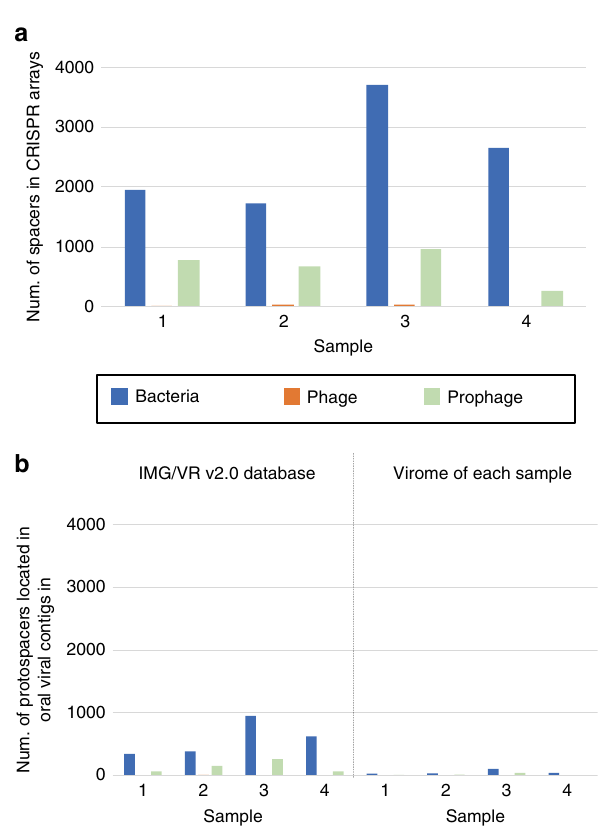
Fig. 5 Distribution of CRISPR spacers. a The number of spacers in CRISPR arrays found in the bacterial contig, phage, and prophage regions. b The number of protospacers located in oral viral contigs in either the IMG/VR v2.0 database (left) or in those contigs assembled in each sample